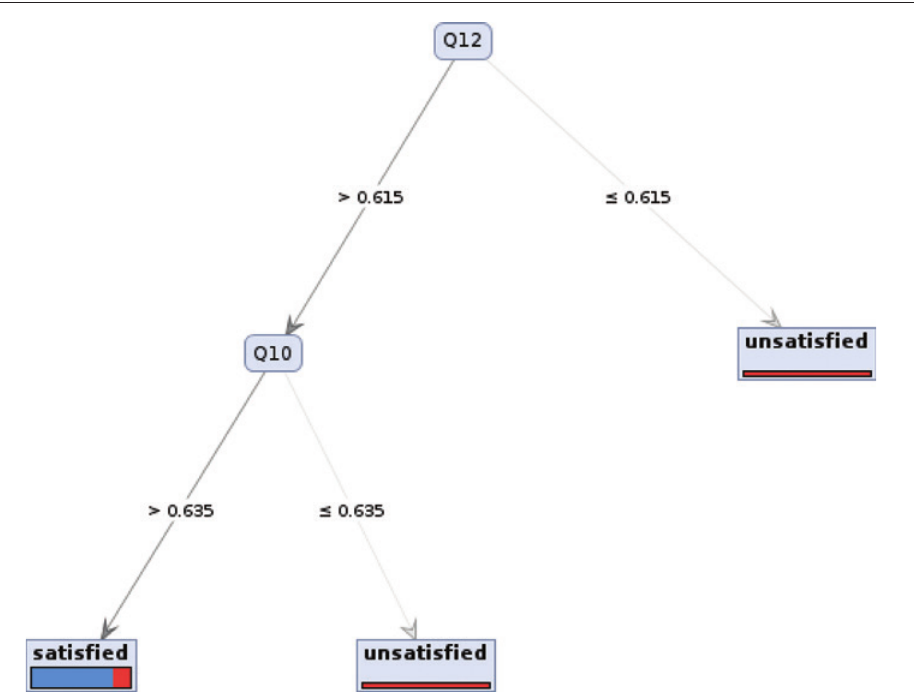
Figure 9: AI-generated tree model showing how Q22 satisfaction can be predicted from other NSS questions, in computer science, for Million+ Group providers